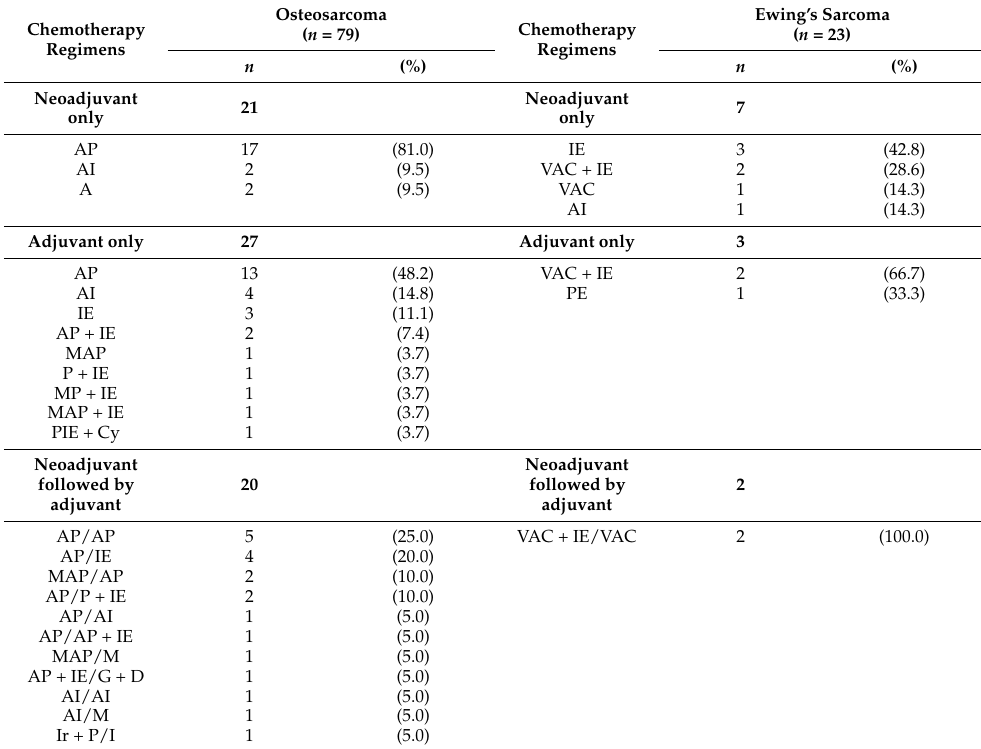
Table 2. The chemotherapy prescribing patterns for osteosarcoma and Ewing’s sarcoma. Chemotherapy